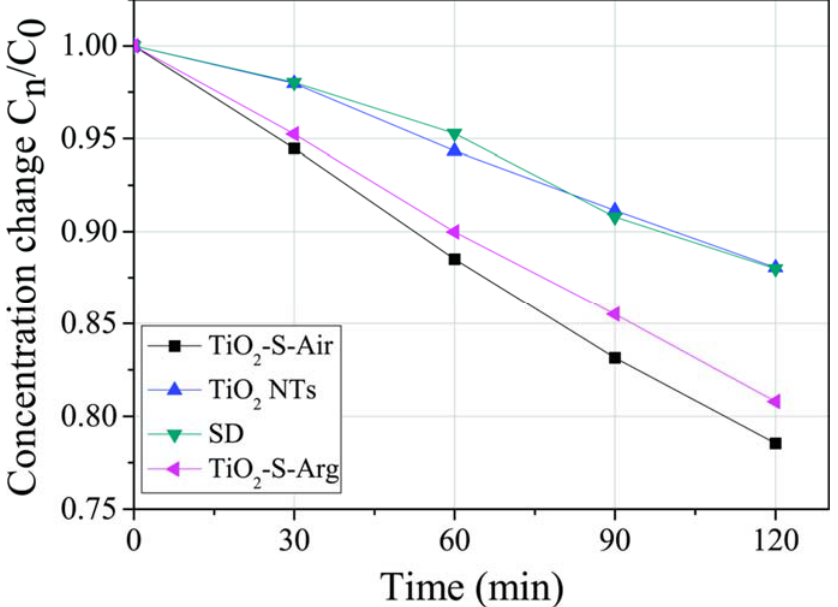
Figure 7. Kinetics of decomposition of methylene blue dye molecules on the surface of TiO 2 NTs, TiO 2 -S-Air, TiO 2 -S-Arg samples and, for comparison, without a catalyst (SD) under illumination in the visible region.